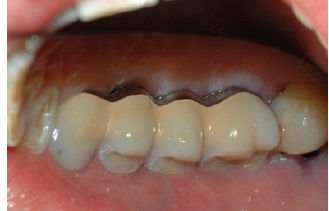
Figure 13. Cementing the superstructure.